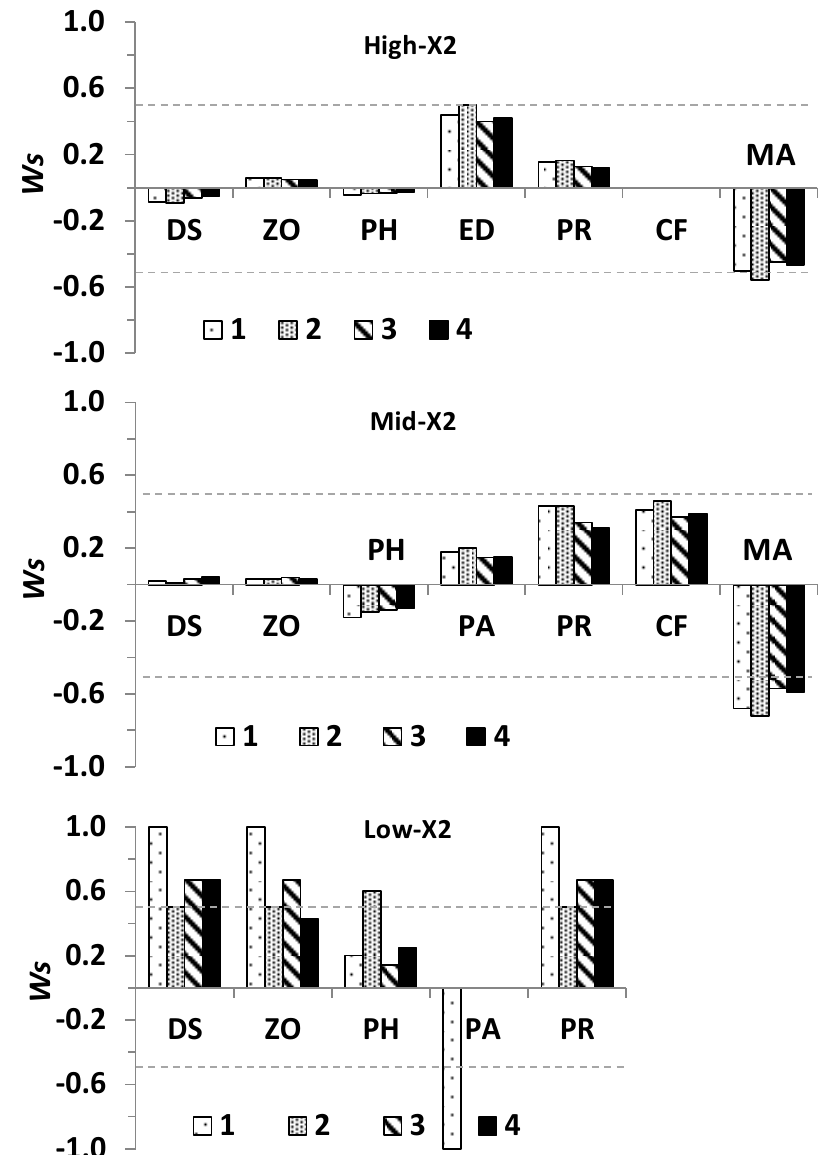
Figure 5. Predicted direction of change and its uncertainty for community variables based on signed weighted predictions ( Ws ) at low-, mid-, and high-X2 positions under outflow–input scenarios (1–4, Figure 4). Values of | Ws | for each community variable range between unconditional sign determinacy (1) and complete uncertainty (0), with | Ws | between 0.50 (dotted line) and ≤ 1 indicating high sign determinacy.